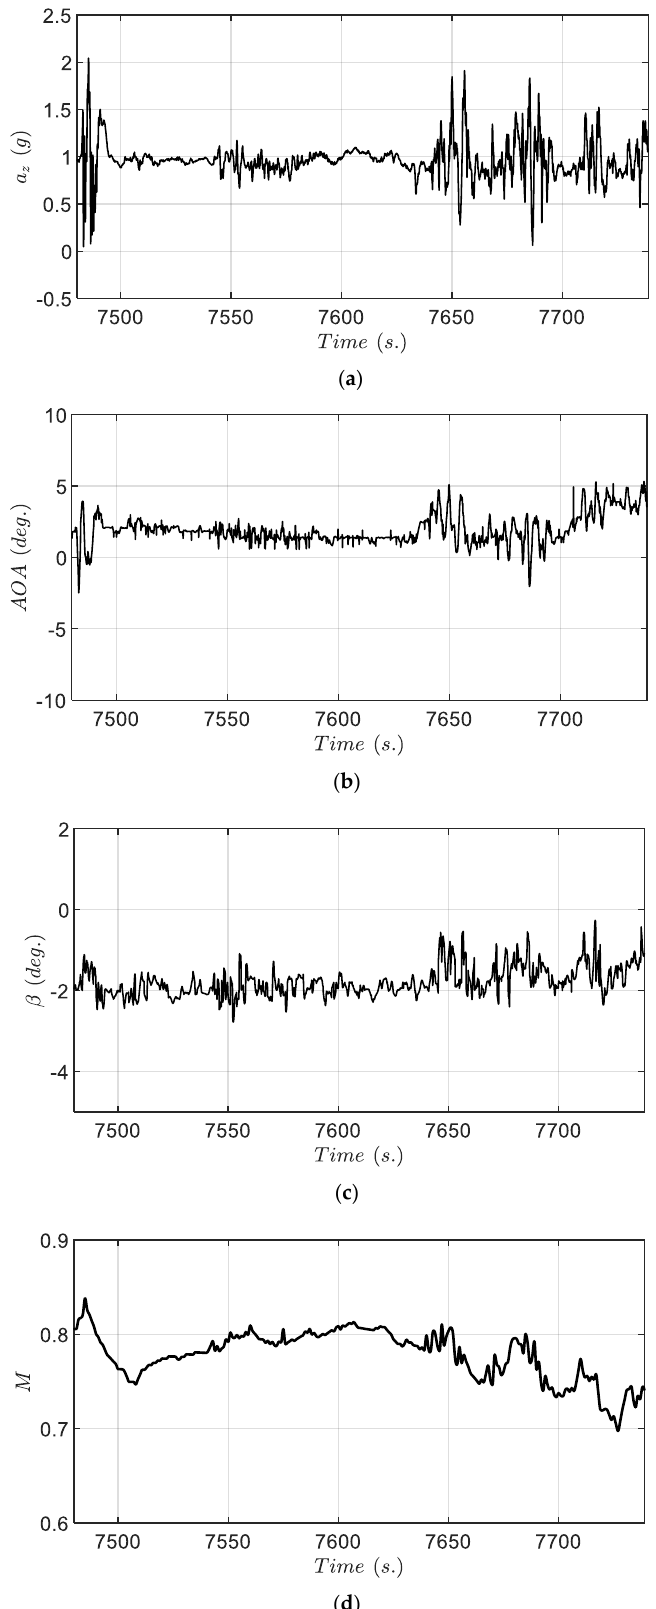
Figure 4. Time history of main flight variables in severe clear-air turbulence. ( a ) Time history of normal acceleration ( a z ); ( b ) Time history of angle of attack (AOA); ( c ) Time history of sideslip angle ( β ); ( d ) Time history of Mach number.